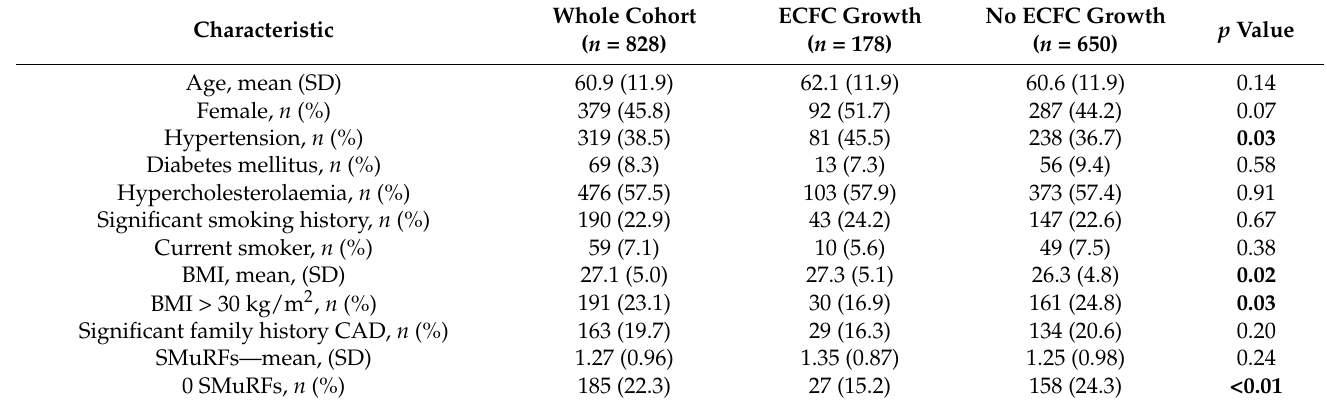
Figure 2. Characteristics of the patient derived ECFCs lines. ECFCs obtained from adult peripheral blood presented classical characteristics of ECFCs. ( A ) Bright-field images show an early colony of ECFCs and ( B ) a mature culture of ECFCs (passage 4). Scale bar = 200 µm. ( C ) Bright-field image of Matrigel tube formation after 6 h. Scale bar = 500 µm. ( D ) Fluorescent microscope images showing NO production of ECFCs in green using DAF-FM Diacetate (4-Amino-5-Methylamino-2 ′ ,7 ′ -Difluorofluorescein Diacetate) and DAPI staining of cells treated or not with 1 µM of Acetylcholine (Ach) for 15 min. White arrows indicate cells positively stained. Cells that were not stained with DAF-FM were used as negative control. Scale bar = 200 µm. ( E ) Flow cytometry analysis for the characterisation of cell membrane markers of ECFCs. Representative pictures of the gating and a table showing the mean percentage of positive cell population ± SEM of n = 4 individual patient derived ECFC lines is provided. Table 1. Baseline characteristics of the population of